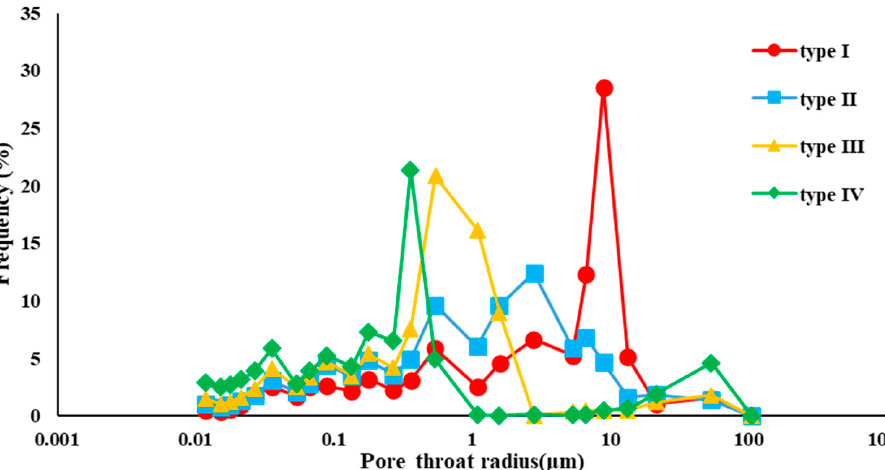
Figure 6. Pore throat distribution of the seven samples from HPMI analysis (Type I: Sample 5; Type